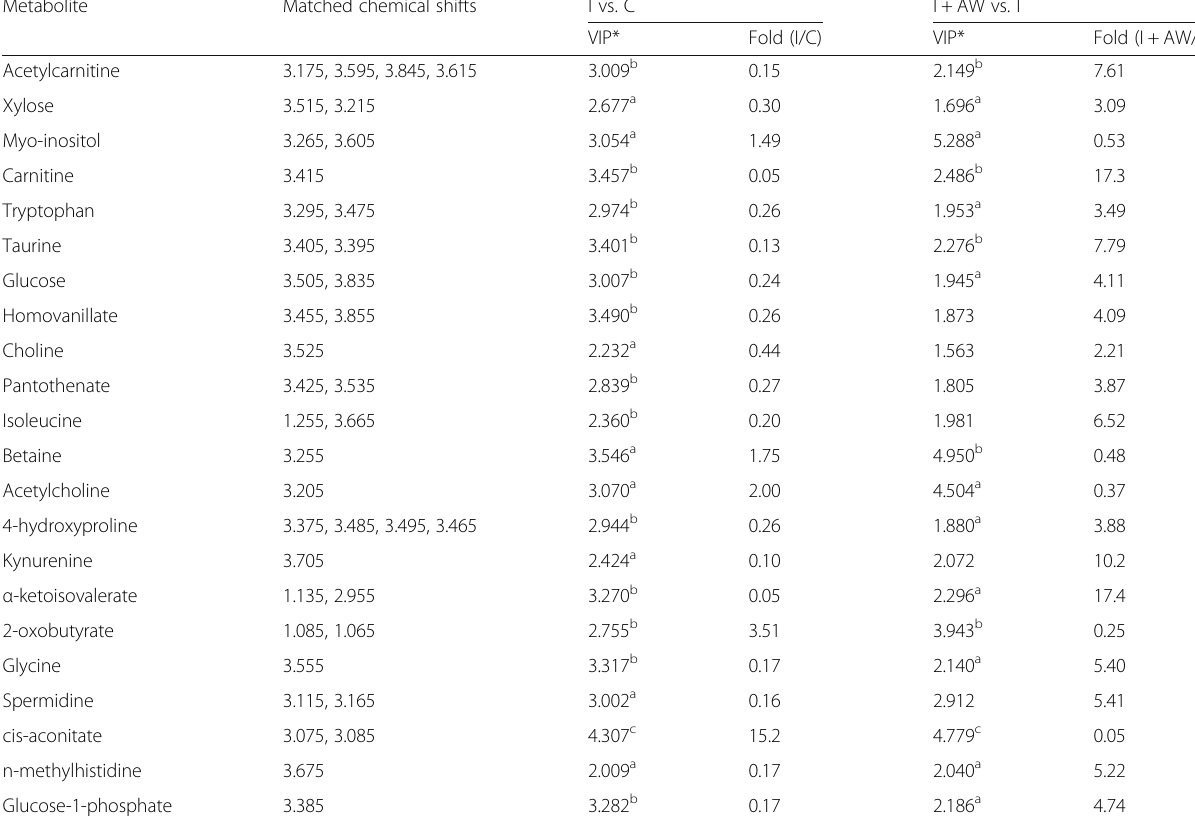
Table 4 Differentially expressed tissue metabolites between normal controls and rats with gastric ulcer and between gastric ulcer and after treatment with AW extract